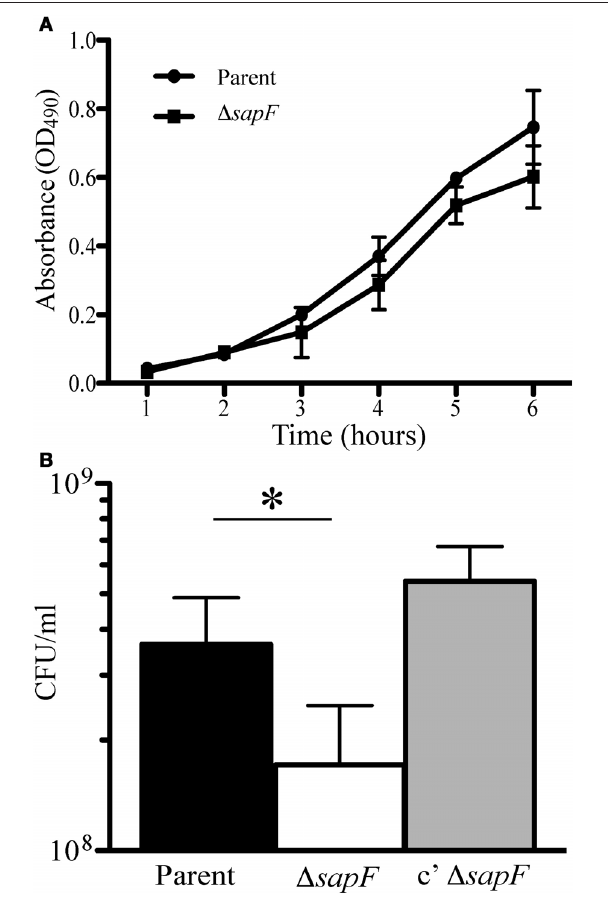
FIGURE 2 | Growth characteristics in the absence of the SapF ATPase. The parent strain (circle) and SapF-deficient strain (square) were grown overnight on chocolate agar, diluted in DIS medium, matched for optical density (OD 490 ) and inoculated into DIS medium containing 2 μ g heme/mL (A) . Growth was assessed by measuring the OD 490 every hour for 5h. Error bars represent the standard deviation of the mean of cultures assayed in triplicate from three independent assays ( n = 2). (B) The parental strain (black bar), the SapF-deficient strain (white bar), and the complemented SapF-deficient strain (gray bar) were incubated in DIS medium in the absence of heme-iron for 16 hours. The resultant cultures were matched for optical density (OD 490 ) and plated for number of CFU. * denotes p < 0 . 05 by a two-tailed Student’s t -test ( N = 5).